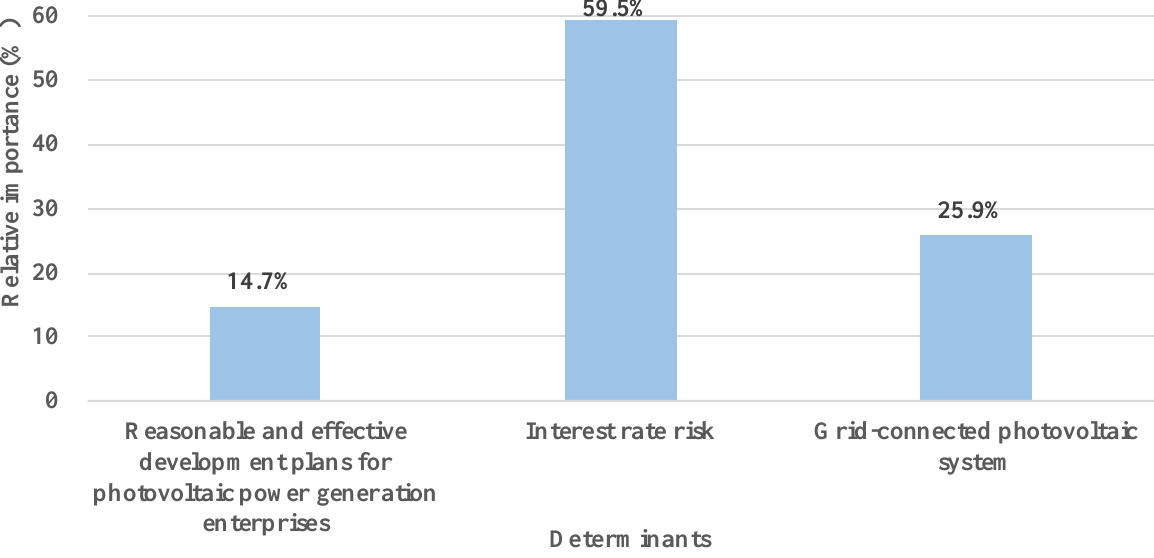
Figure 4. Relative importance of demand condition determinants.